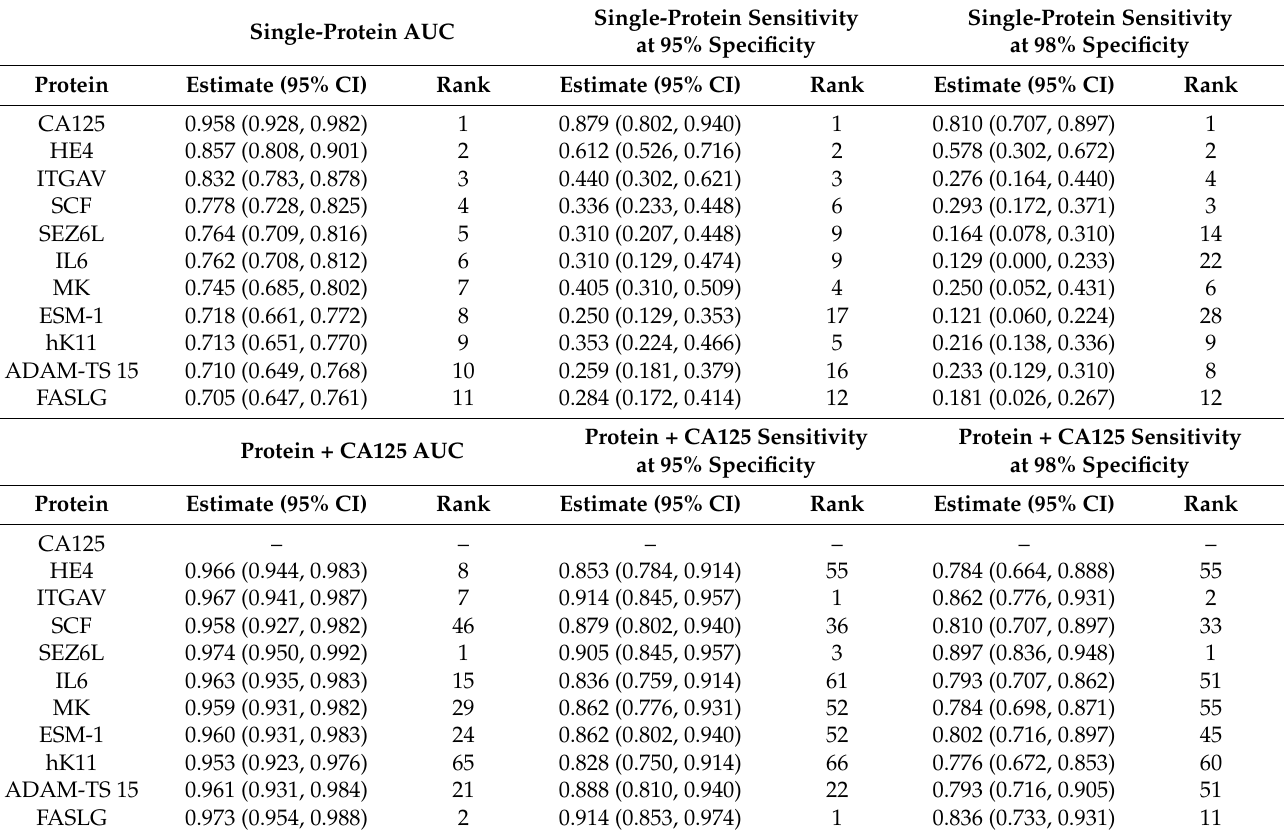
Table 3. AUC and sensitivities at 95% and 98% specificity for the 11 proteins with AUC > 0.70 comparing women with ovarian cancer to healthy women in Cohort #1. Summaries are also given for the proteins when combined with